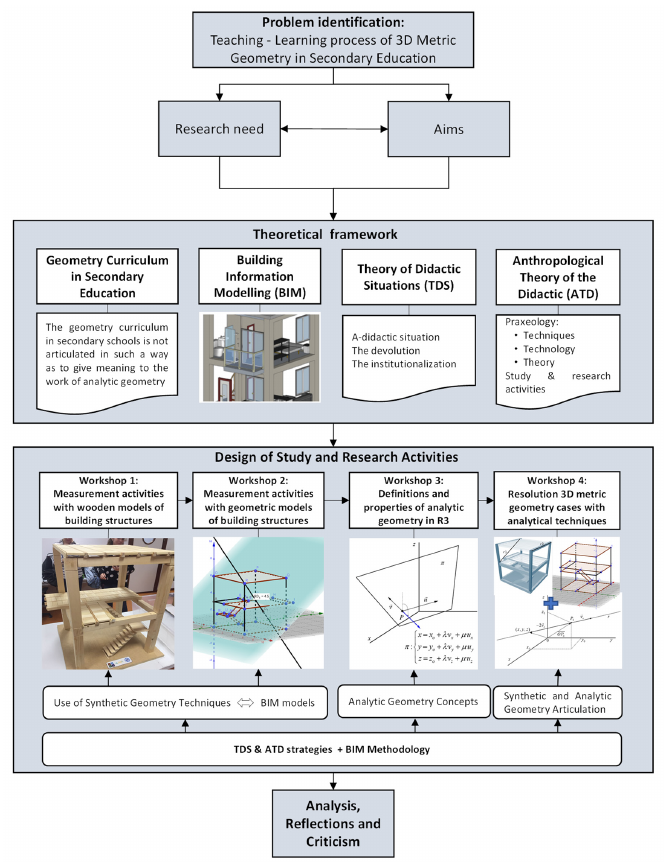
Figure 3. Methodology workflow.